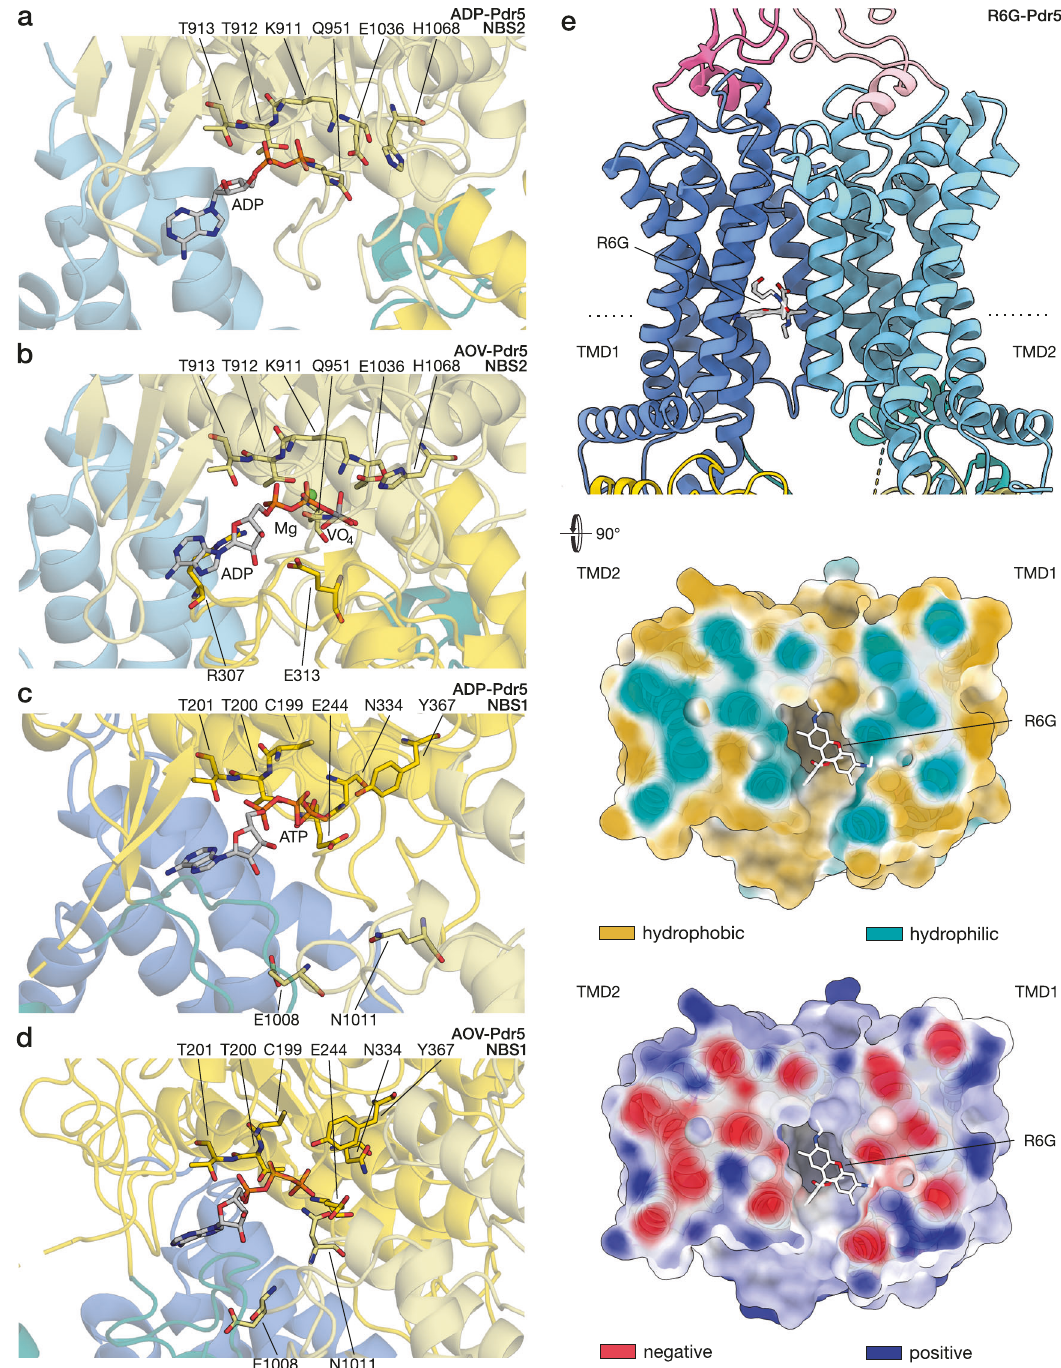
Fig. 4 Nucleotide and substrate binding to Pdr5. The panels illustrate the contacts between Pdr5 with ( a – d ) nucleotides and ( e ) rhodamine 6 G. Some of the residues that are important for nucleotide binding and/or catalysis are highlighted and labelled (cf. Supplementary Fig. 10). The domain colouring follows the scheme of the previous fi gure. a The catalytic site (NBS2) of Pdr5 in inward-facing conformation (ADP-Pdr5) with bound ADP. b The catalytic site of outward-facing Pdr5 (AOV-Pdr5) in a vanadate-trapped state that mimics the intermediate step of hydrolysis with an ADP-orthovanadate molecule. A co-ordinated magnesium ion is depicted as a green sphere. c The deviant, inactive site (NBS1) of Pdr5 in the inward-facing conformation (ADP-Pdr5), showing the bound ATP. d The same site in the outward-facing conformation (AOV-Pdr5), The residues surrounding the nucleotide are at the corresponding positions of the catalytic site. e Side view and cross-section of the transmembrane part of Pdr5 in inward-facing conformation (Pdr5-R6G). Dotted line on the side-view denotes the position of the cross-section. The ef fl ux substrate rhodamine 6G is bound in the entrance cavity between TMD1 and TMD2 . The cross-section of Pdr5 is coloured by hydrophobicity, from turquoise (hydrophilic) to tan (most hydrophobic), and electrostatic potential, from red (negative) to blue (positive). Abbreviations: AOV, ADP-orthovanadate; R6G, rhodamine 6G; TMD, transmembrane